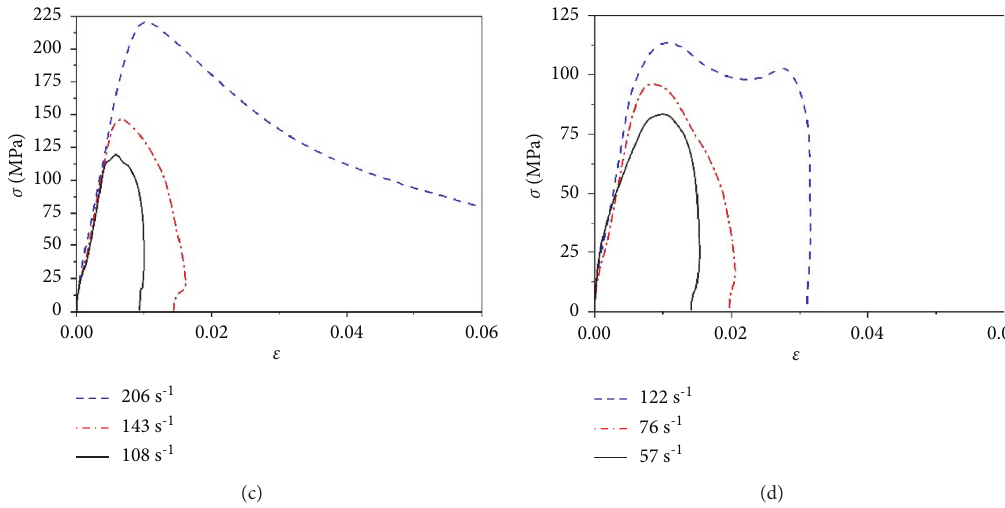
Figure 7: Dynamic compressive stress-strain curves of high strength SFRSCC: (a) HC-F0.5; (b) HC-F1.0; (c) HC-F1.5; (d) HC-F2.0.